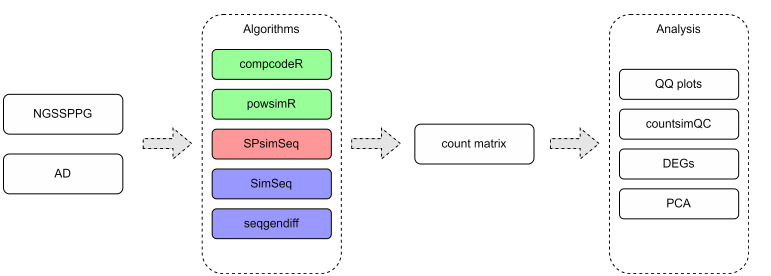
Figure 1. Methodological framework for synthetic RNA-seq data generation for benchmarking of algorithms for statistical and pattern recognition analyses.